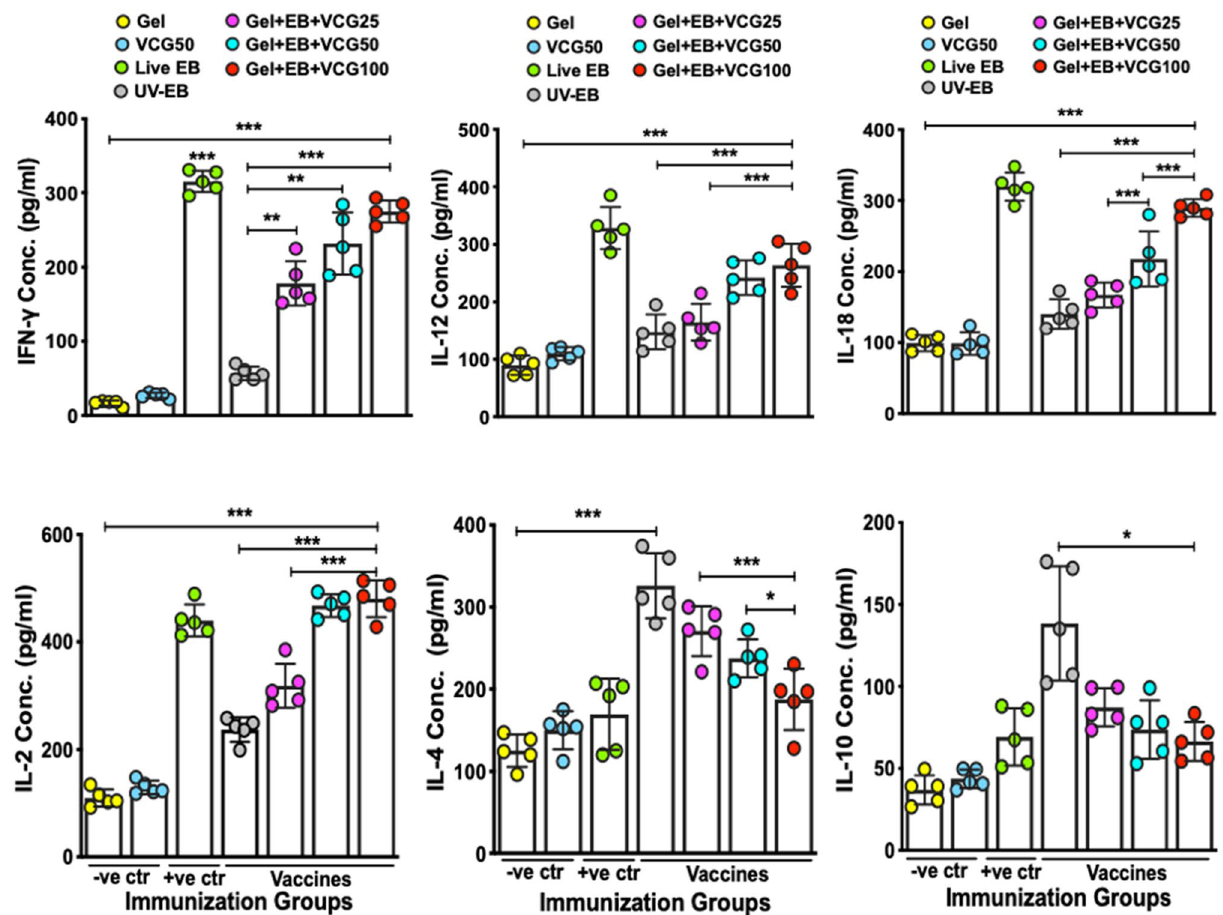
Figure 6. Concentration of cytokines in lung lavage fluids of chickens immunized with UV-inactivated EB in combination with different VCG doses. Groups of chickens (8/group) were immunized and boosted IN as described in the materials and methods section. Lung lavage fluids were obtained 3 weeks after the booster immunization. The amount of Th1 (IFN-γ, IL-2, IL-12, IL-18), Th2 (IL-4) and anti-inflammatory (IL-10) cytokines in supernatants of lung lavage fluids was quantified using commercial cytokine assay kits from Kingfisher (Kingfisher Biotech Inc, Saint Paul, MN) and Cusabio (Cusabio, Wuhan, China). The concentration of the cytokines in each sample was extrapolated from a standard calibration curve generated simultaneously. Bars represent the mean concentrations (± SD) from 8 chickens and are the results of one of two independent experiments with similar results. Significant differences between groups were evaluated by One-way ANOVA with Tukey’s post multiple comparison test at p *** < 0.001, p ** < 0.01 and p * < 0.05. Abbreviations: − ve ctr negative controls; + ve ctr positive